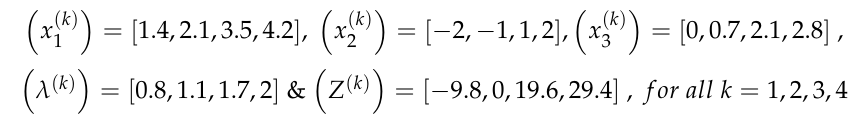
(cid:16) (cid:17) ( k ) = [ − 2, − 1, 1, 2 ] , x 2 (cid:16) (cid:17) = [ − 9.8, 0, 19.6, 29.4 ] , f or all k = 1, 2, 3, Z ( k )